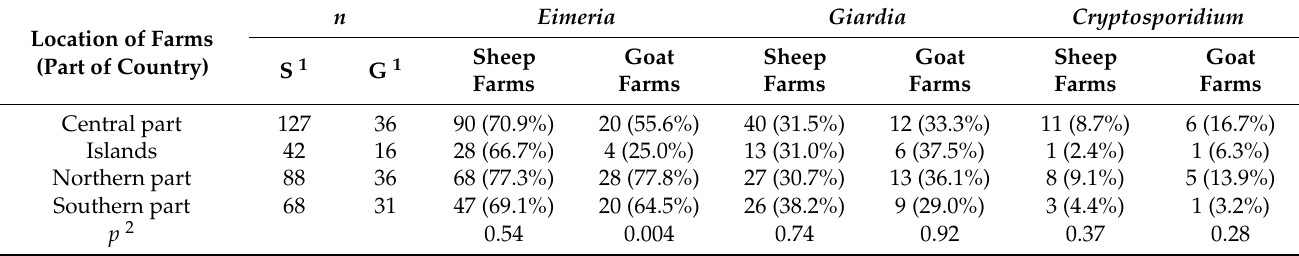
Table 2. Presence of protozoan parasites in pooled faecal samples from 444 small ruminant farms